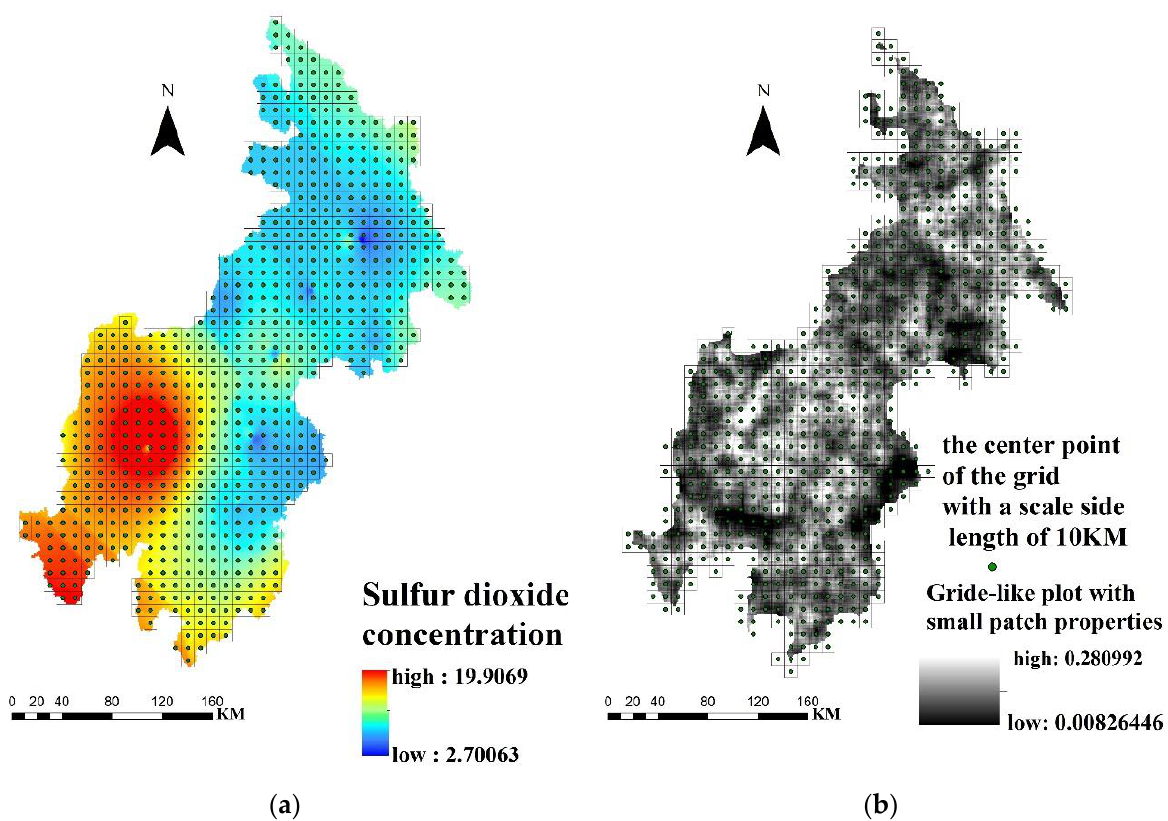
Figure 3. Unified grid with a cell size of 10 km × 10 km ( a ). SO 2 ; ( b ). PD index for farmlands.